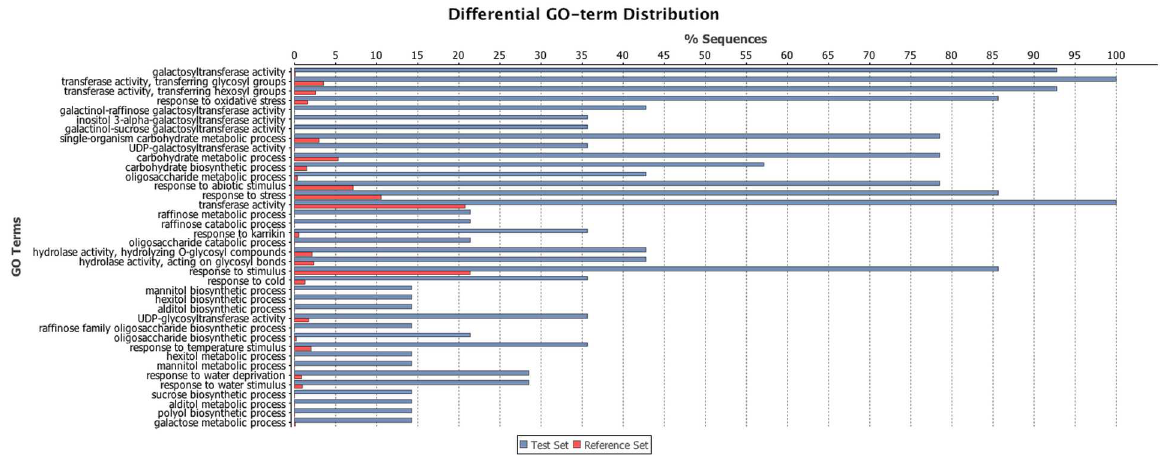
Fig 2. GO term categorization analysis performed by Blast2GO tools for RFO biosynthetic genes. GO categoriesannotatedfor RFOs candidate genes are indicatedin blue; the globaldataset, used as a reference, is indicatedin red. GO categorization analyses were performed using the Blast2GO software with the default